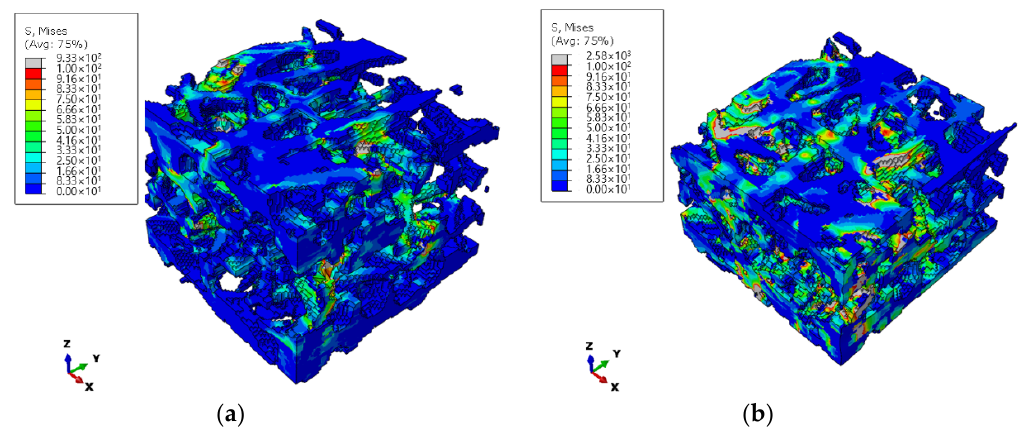
Figure 6. Analysis image of GDL structure at 30% and 50% compression: ( a ) 30% compressed GDL; ( b ) 50% compressed GDL.